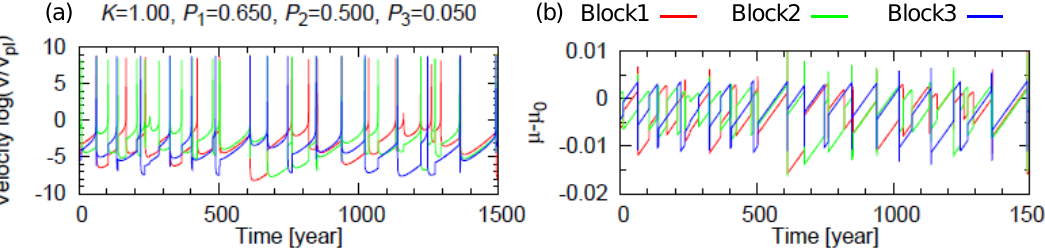
Figure 12. Example histories of (a) V and (b) µ – µ ∗ for pattern 4. The model parameters are set to K = 1 . 00, P 1 = 0 . 650, P 2 = 0 . 500, and P 3 = 0 . 050.